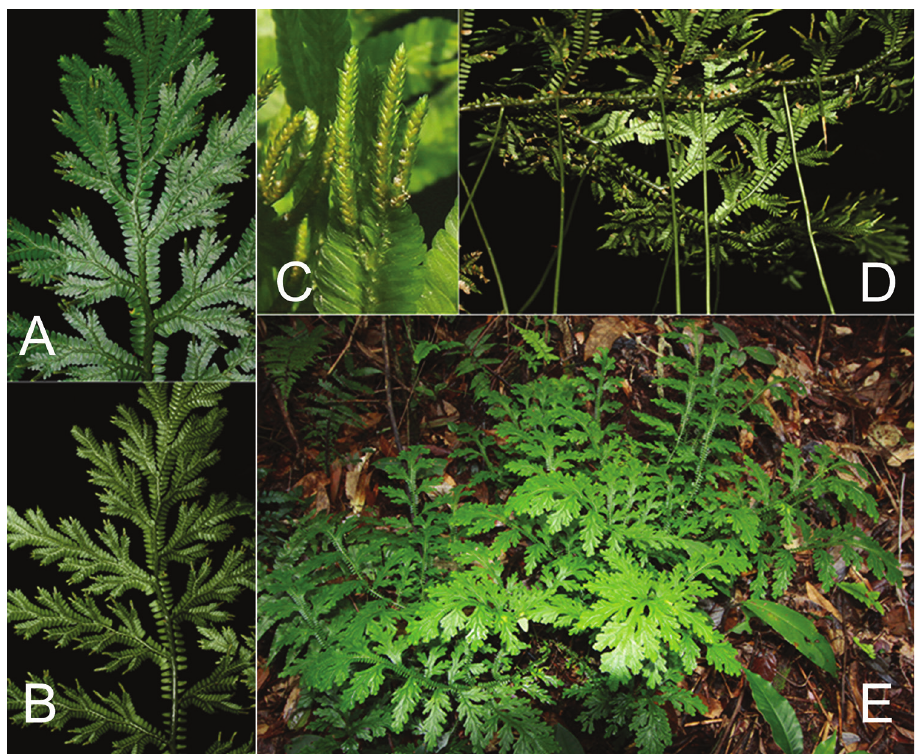
Figure 4. Selaginella guihaia X.C.Zhang, sp. nov. A Dorsal view of branch B Ventral view of branch. C Strobilus D Rhizophore E